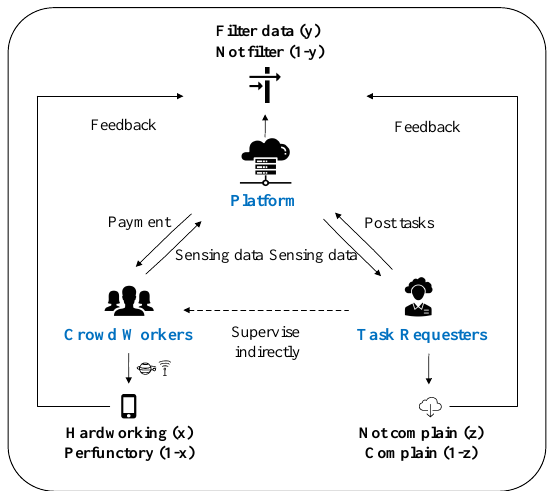
Figure 1. Mobile crowdsourcing